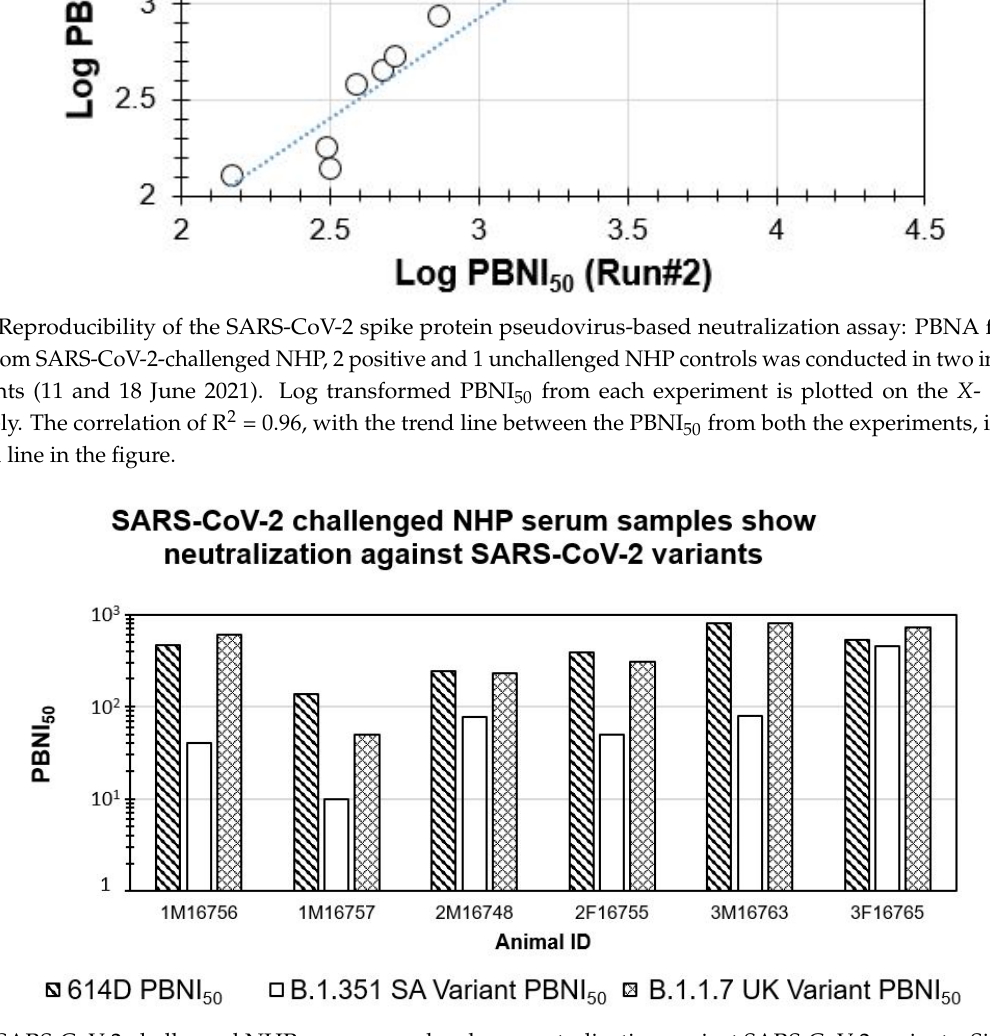
Figure 3. SARS-CoV-2-challenged NHP serum samples show neutralization against SARS-CoV-2 variants: Six (6) serum samples from SARS-CoV-2-challenged NHPs (N = 2 from each species: rhesus macaques (1M16756, 1M16757), cynomolgus monkeys (2M16748, 2F16755), African green monkeys (3M16763, 3F16765)) were subjected to PBNA using the pseudoviruses for 614D and variants as described in Section 2. The PBNI 50 for each animal is shown on the Y -axis. Crosshatch-filled bars show the average PBNI 50 from two independent experiments for 614D, plain bars show the PBNI 50 for the B.1.351 SA variant, diamond-filled bars show the PBNI 50 for the B.1.1.7 UK variant.